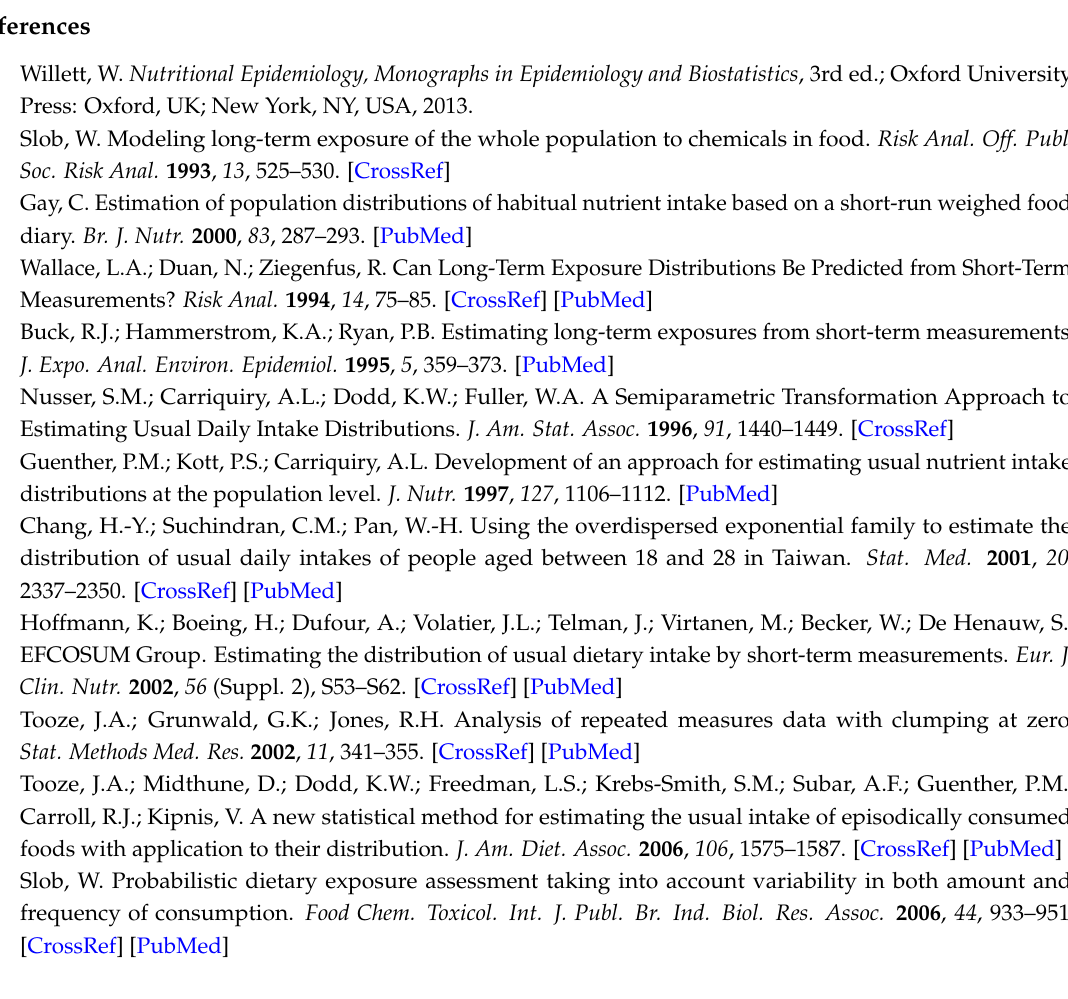
Table S1: the number of simulated samples for which the between-person variance was estimated as zero; Table S2: Bias and relative bias of estimates obtained with each method for each scenario p λ “ 0.2 q ; Table S3 : MSEs of estimates obtained with each method for each scenario p λ “ 0.2 q and Figure S1: Boxplot of biases calculated for each method and scenario, all results for the methods that had a positive estimate for the between-person variance. Table S4: Bias and relative bias of estimates obtained with each method for each scenario p λ “ 0.2 q and Table S5: MSEs of estimates obtained with each method for each scenario p λ “ 0.2 q , both for each method without excluded samples when other methods estimated between-person variance equal to zero. All supplementary tables and figures had more percentile results than in the article (5th, 25th, 75th, and